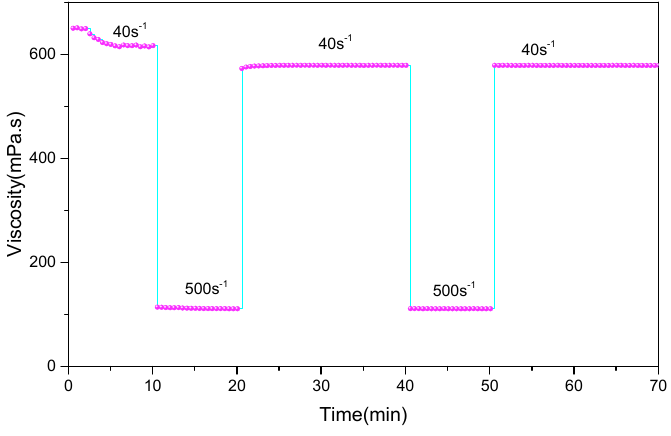
Figure 5. Shear recovery test of the 0.6 wt% PAANM solution.